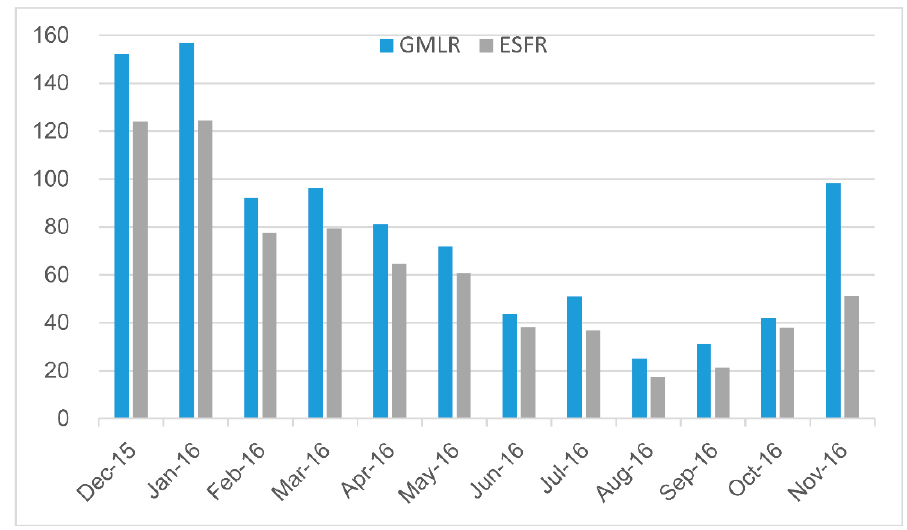
Figure 5. Monthly model leave-one-out cross validation results: test dataset MSE of GMLR and ESFR models.